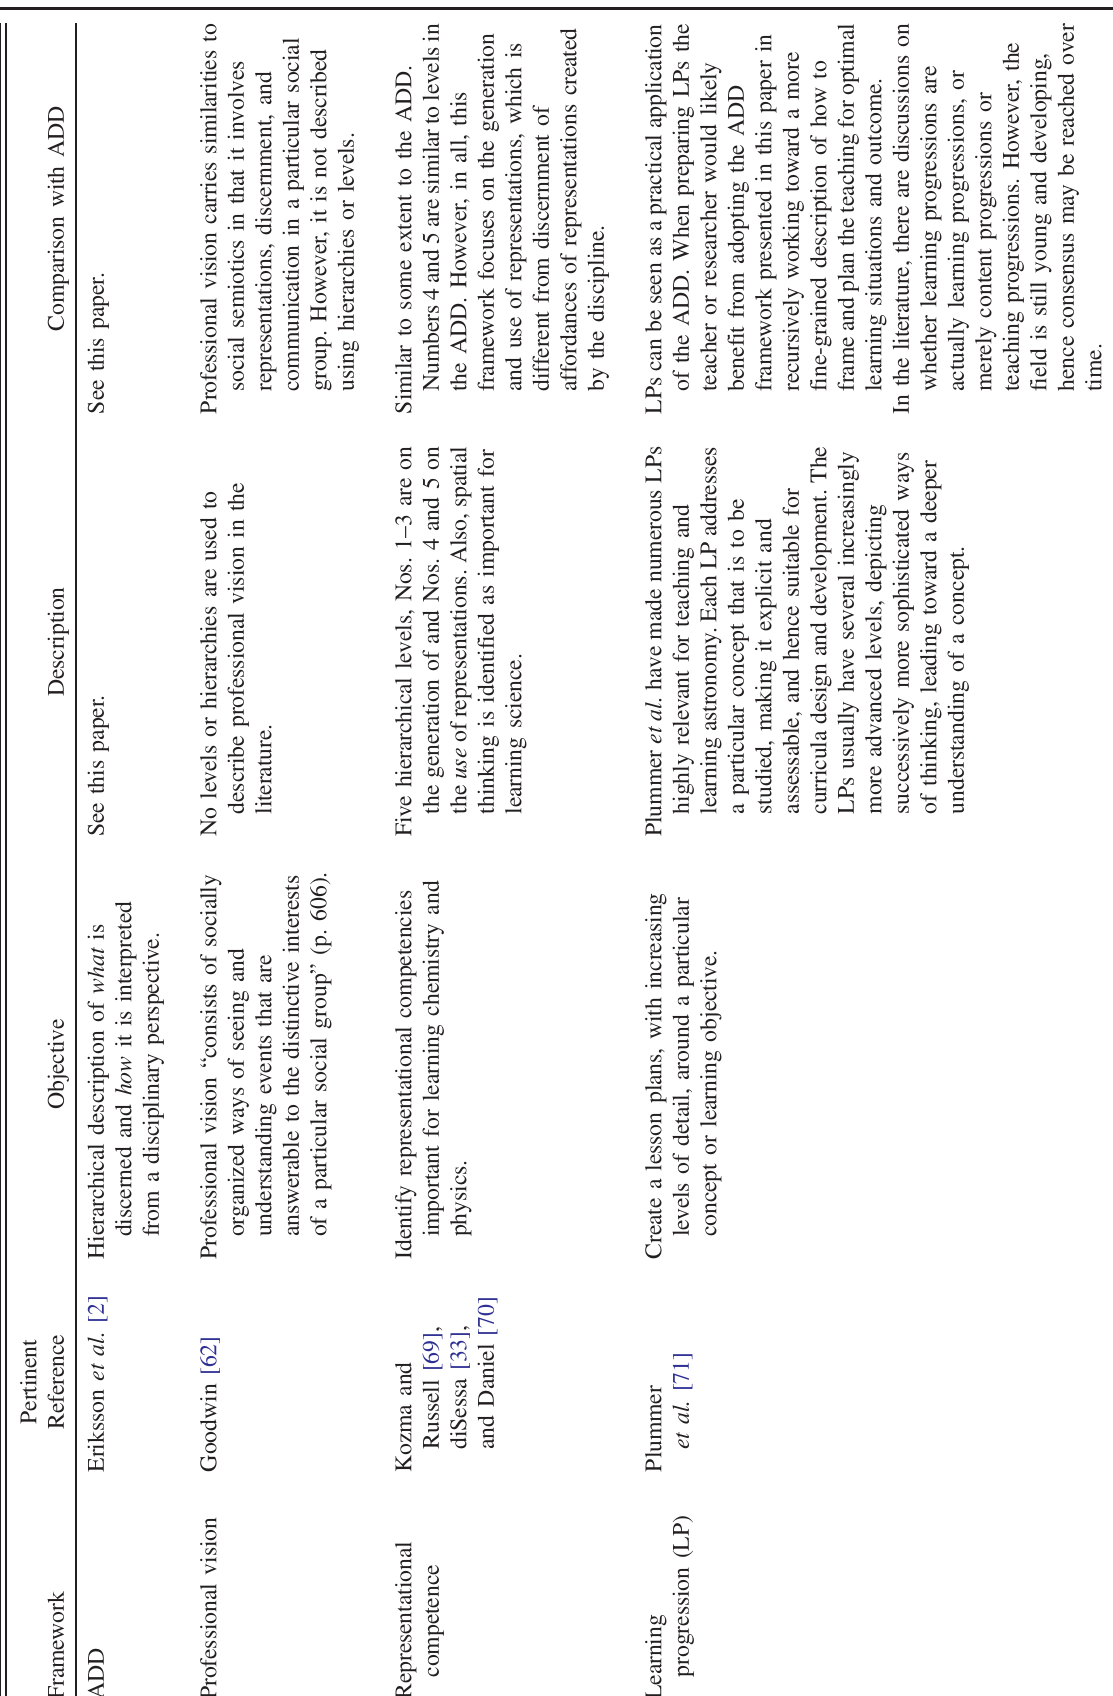
DISCIPLINARY DISCERNMENT: READING THE